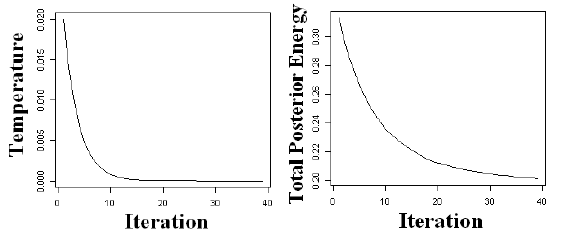
Table 2. Accuracy assessment of SVM-MRF method